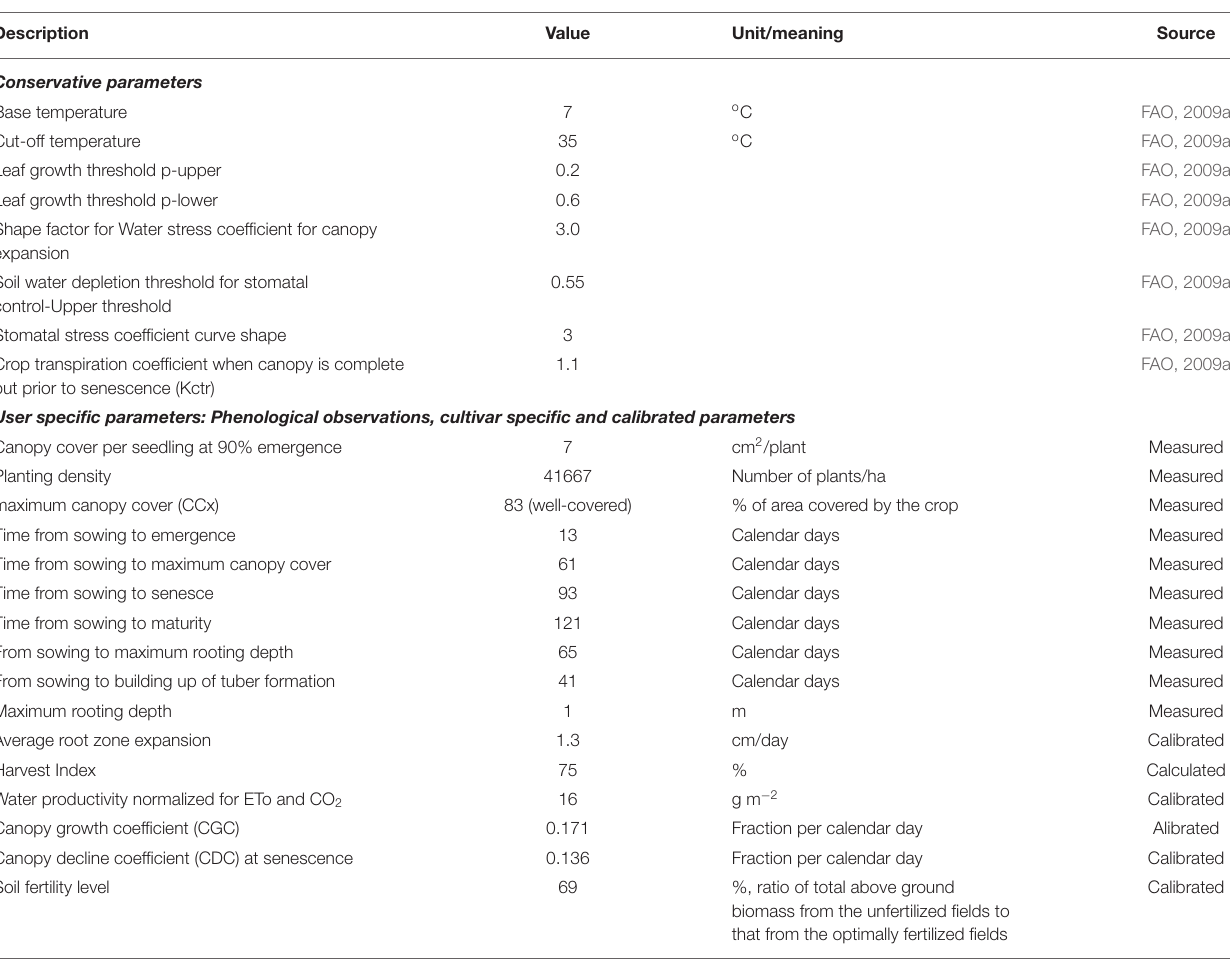
TABLE 2 | Conservative and user-specific potato (crop) input parameters of Aqua